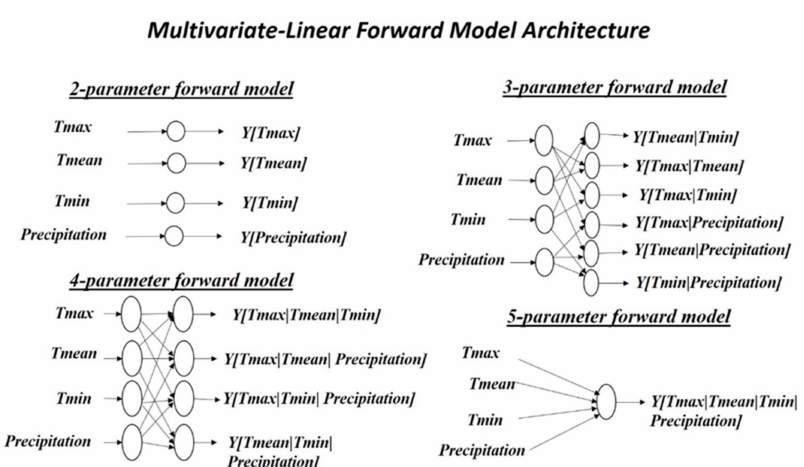
Figure 2. The model architecture of multivariate linear regression. The two–parameter, three– parameter, four–parameter, and five–parameter models are